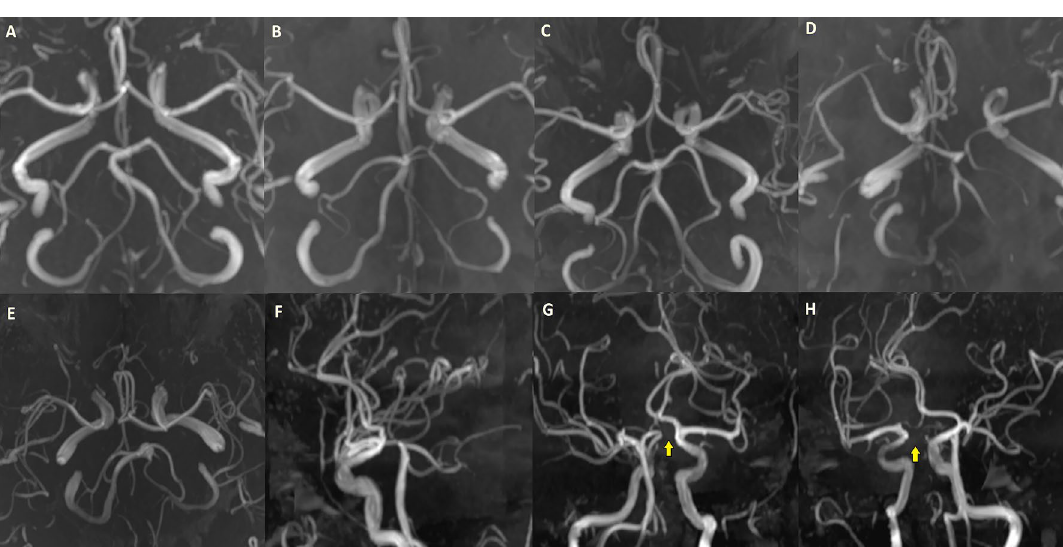
Figure 5. Some samples of MR angiography images from our patient population, classified as “partially incomplete” circle of Willis. Type E posterior circulation with the absence of both PComs ( A ). Type D posterior circulation with the absence of the right PCom ( B ). Type E anterior circulation with anterior cerebral arteries originating from a common trunk ( C ) Type H anterior circulation with the absence of the left A1 segment ( D ). Another patient with Type E posterior circulation ( E ) and lateral ( F ), right oblique ( G ) and left oblique ( H ) images of the same patient indicate the absence of bilateral PComs (yellow